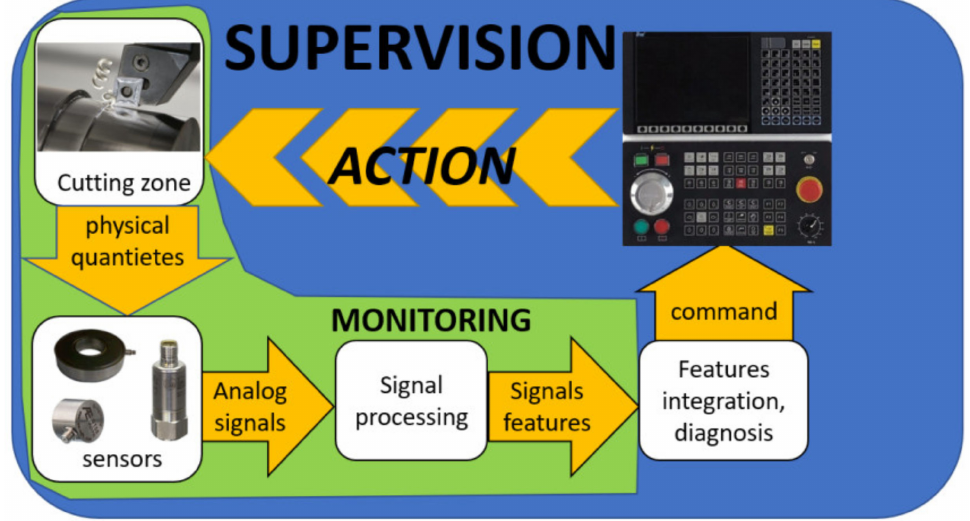
Figure 1. The general structure of a tool and cutting process diagnostic